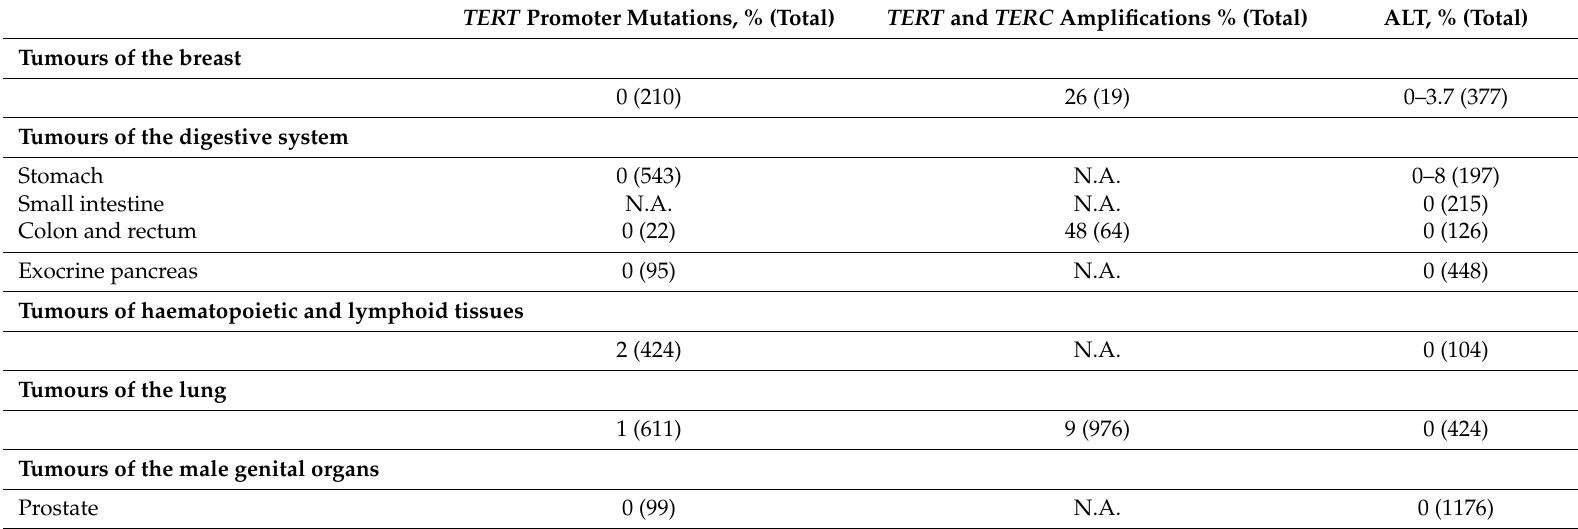
Table 6. Distribution of absent/low frequency telomere maintenance mechanisms (TMMs) in prevalent human tumours. TERT Promoter Mutations, % (Total) Tumours of the